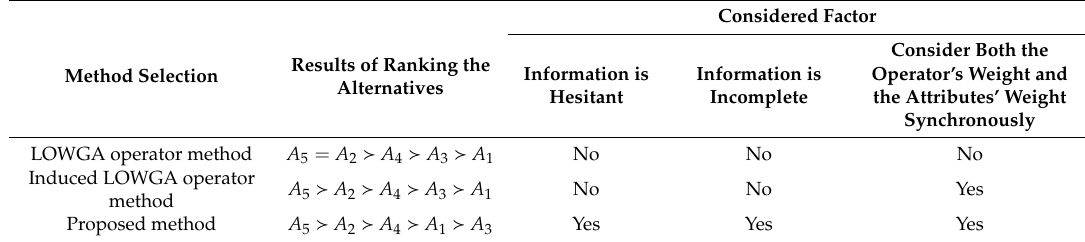
Table 6. The main di ff erences and ranking comparison of the di ff erent